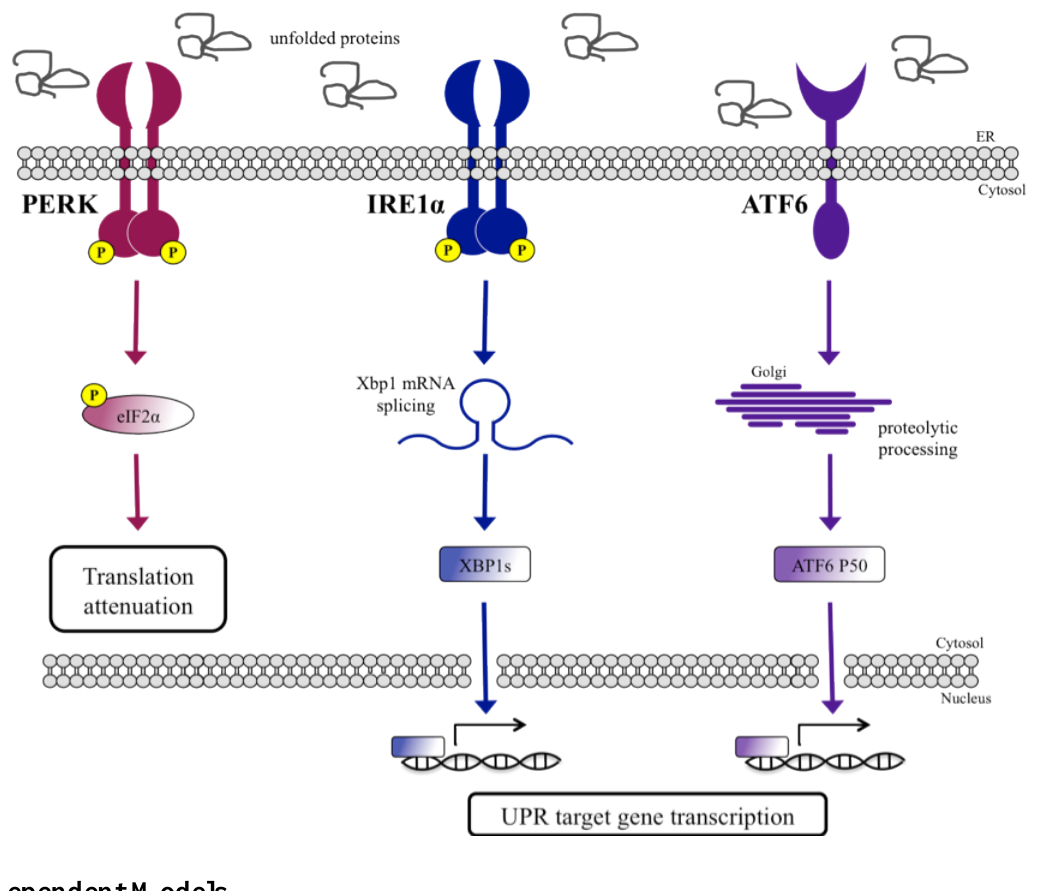
Figure 1. The unfolded protein response in mammals. During ER-stress, the accumulation of unfolded proteins in the ER lumen activates PERK, IRE1 and ATF6. Activated PERK phosphorylates eIF2α resulting in the reduction of protein translation. The active cytosolic domain of IRE1α cleaves and removes an intron from Xbp1 mRNA which then encodes for XBP1s protein. Once activated, ATF6 translocates to the Golgi where it is proteolytically cleaved releasing the active ATF6 P50 fragment. XBP1s and ATF6 P50 transcription factors migrate to the nucleus and activate transcription of UPR target